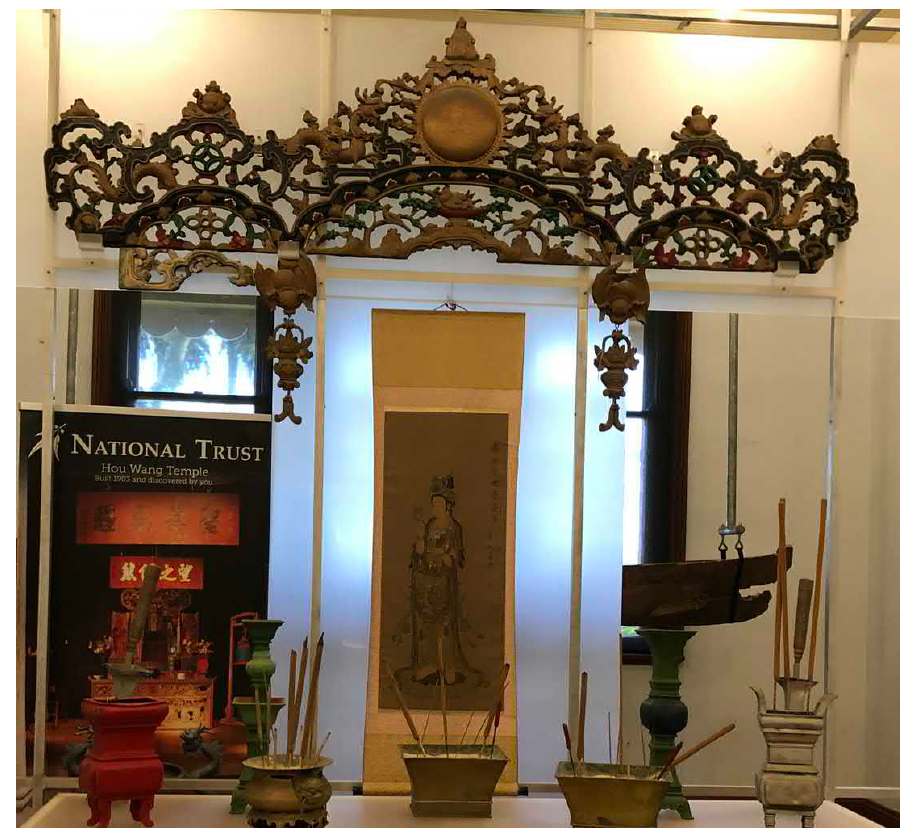
Figure 8: Chinese Temple display, James Cook Museum, Cooktown. (Photo: Anna